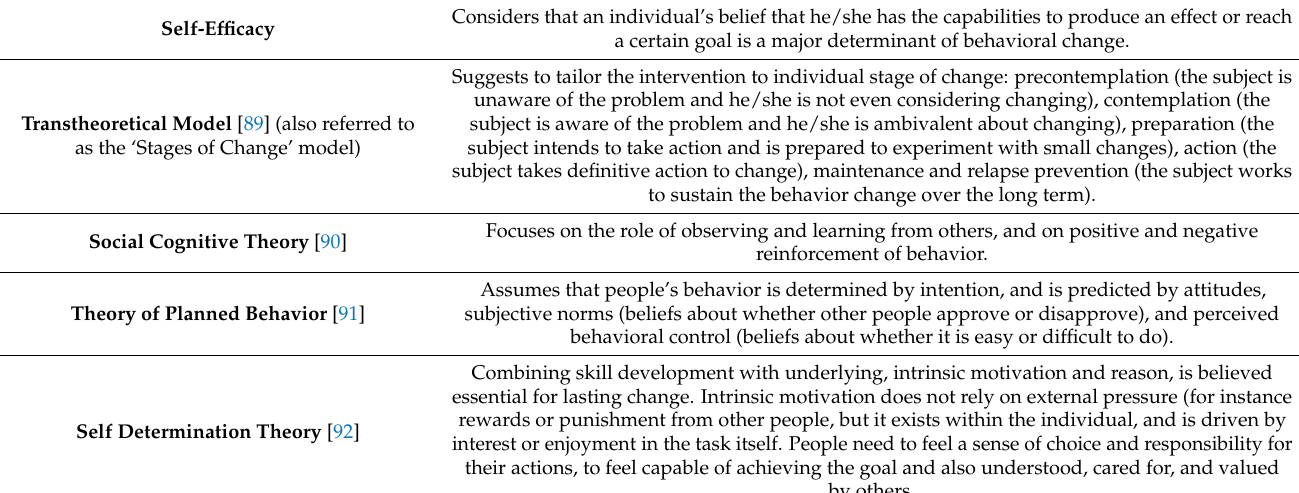
Table 3. Main psychological theories and models of behaviour